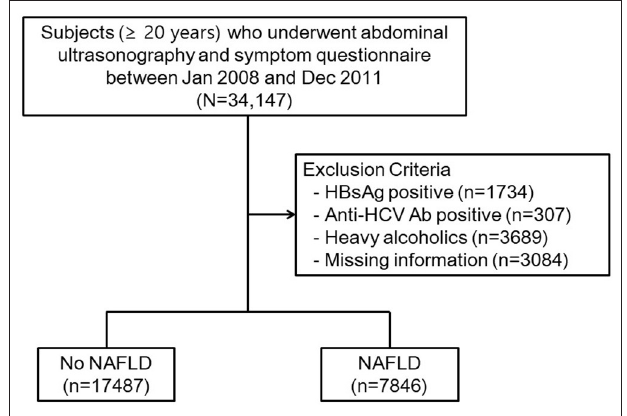
FIGURE 1 | Study population. HBsAg, hepatitis B surface antigen; HCV Ab, hepatitis C virus